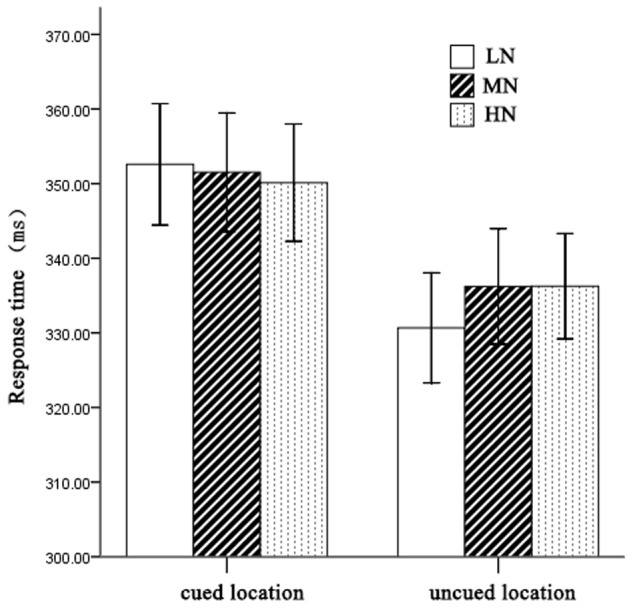
Mean RTs for each condition. Error bars show the SE of each condition.